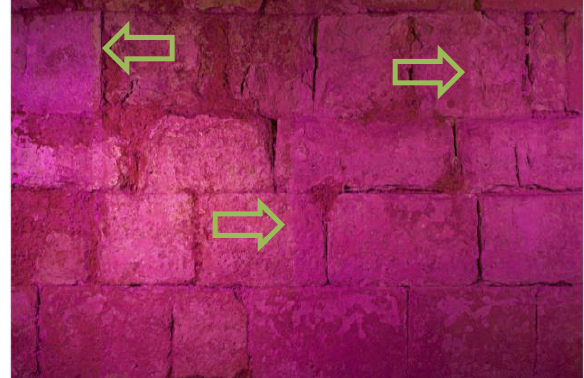
Figure 13. Trial area 3 at Santa Maria de Vitoria. UV-A-fluo- rescence image 2017. Arrow: application